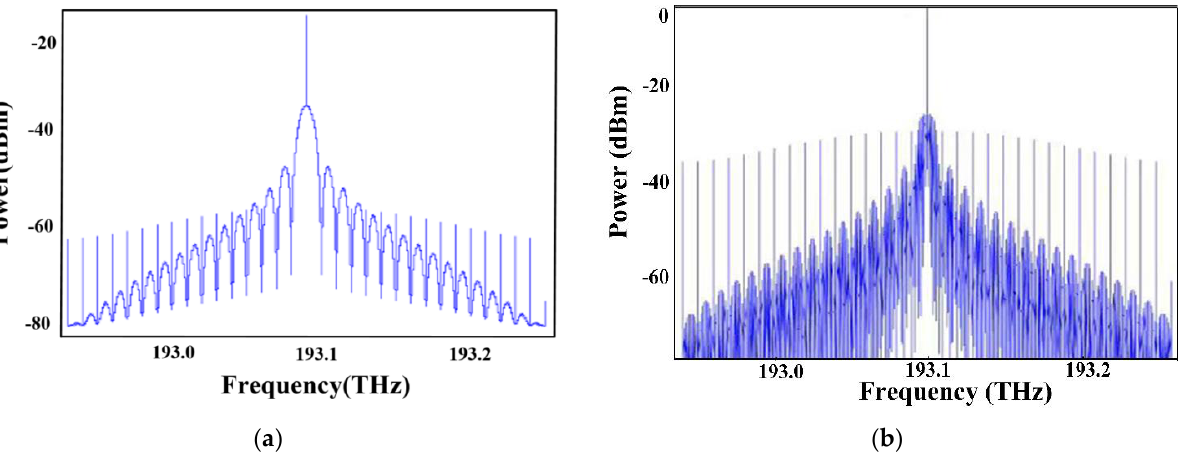
Figure 5. The upstream spectrum of the re-modulated signal ( a ) before; ( b ) after SMF transmission.